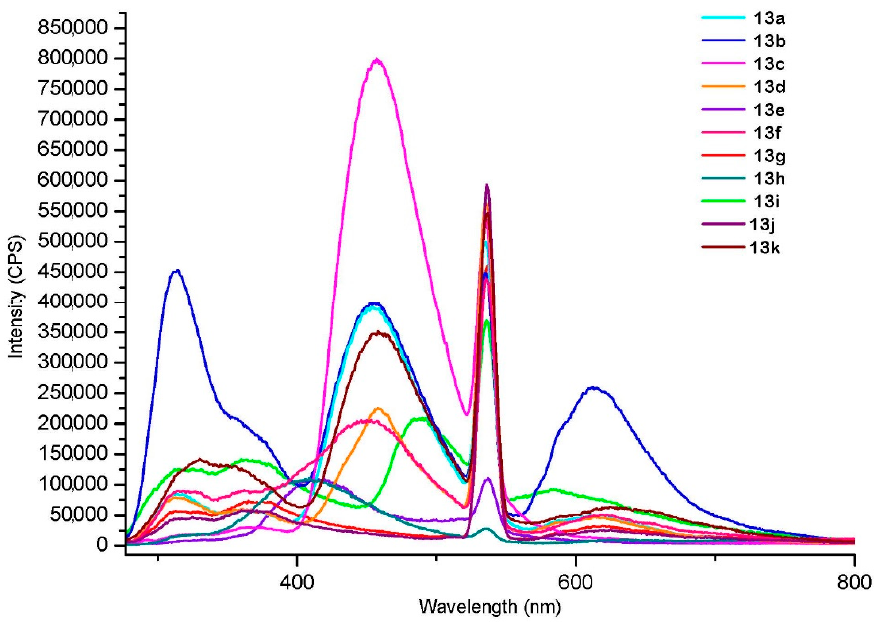
Figure 7. Fluorescence spectra of 13a–k (1 × 10 − 6 M in CH 2 Cl 2 ) excited at 267